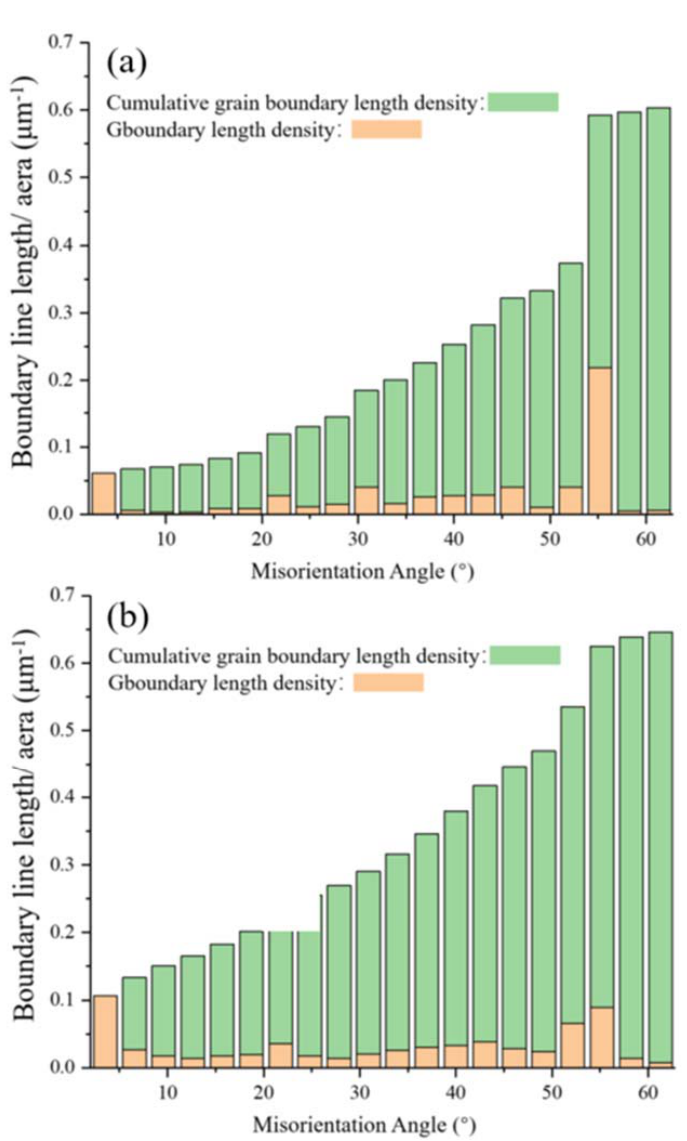
Figure 5. Distributions of grain boundary length density and cumulative grain boundary length density as a function of misorientation angle on the ( a ) XY ‐ plane and ( b ) YZ ‐ plane of the LMD sample.